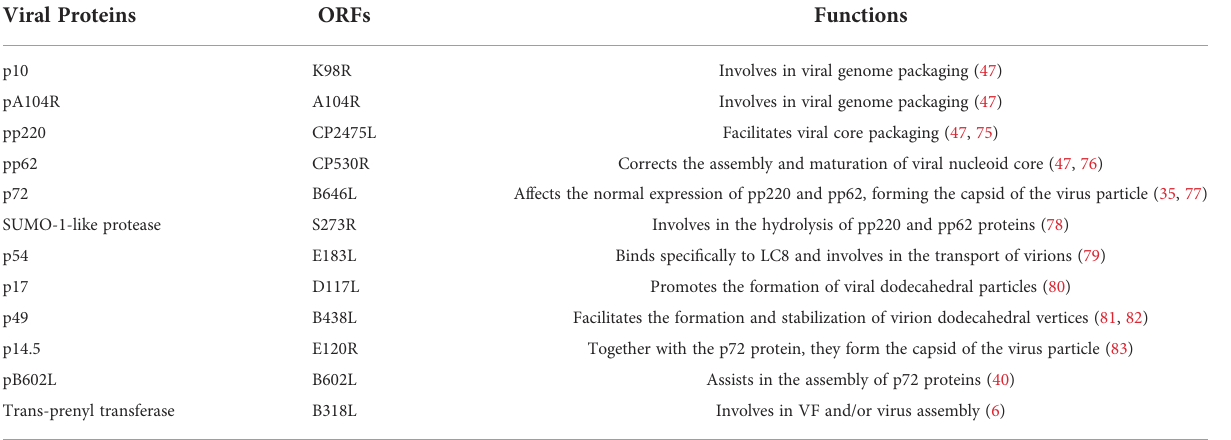
TABLE 5 ASFV encodes related proteins involved in the assembly and release process. Viral